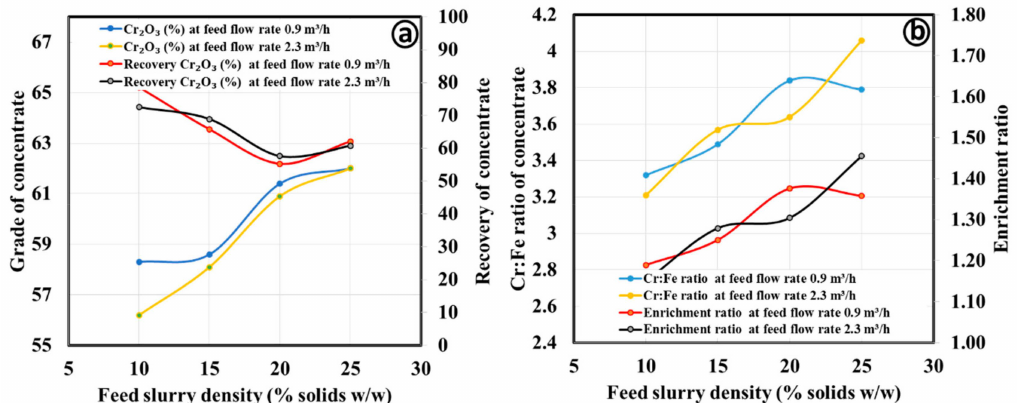
Figure 9. Influence of the feed flow rate and slurry density on the performance of spiral design HG10i in treating fine concentrate ( a ) for grade and recovery; ( b ) for Cr:Fe ratio and enrichment ratio of